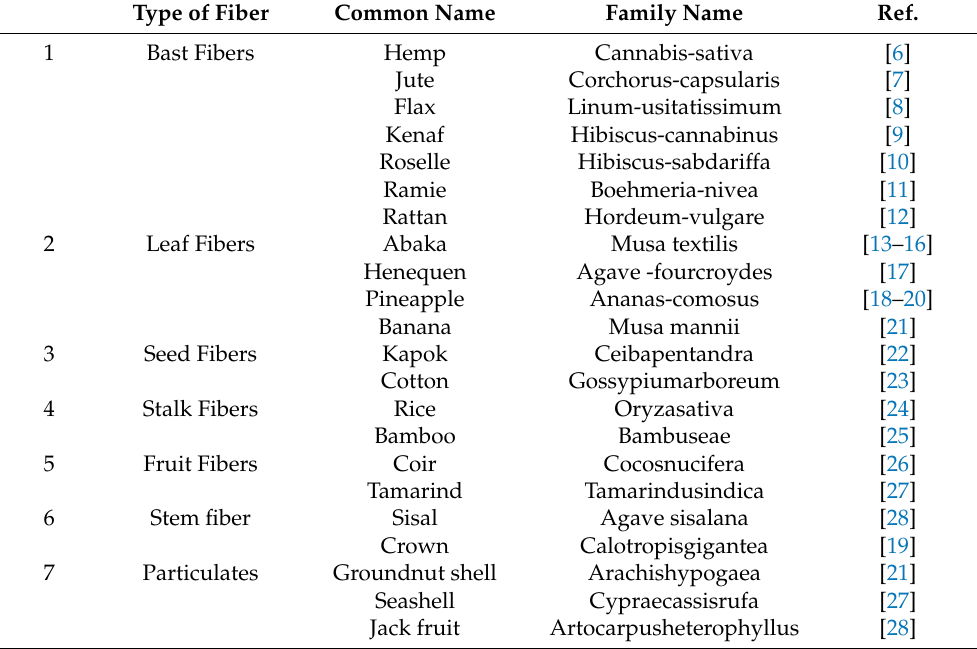
Table 3. Fiber types and their scientific name